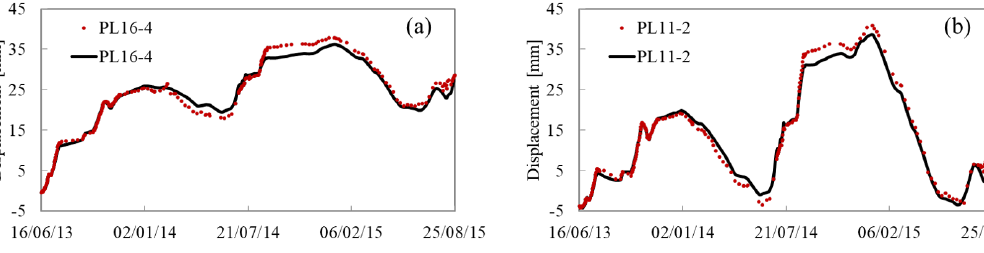
Figure A4. The fitting and forecast results of Class 5: ( a ) IP 16-4; ( b ) IP